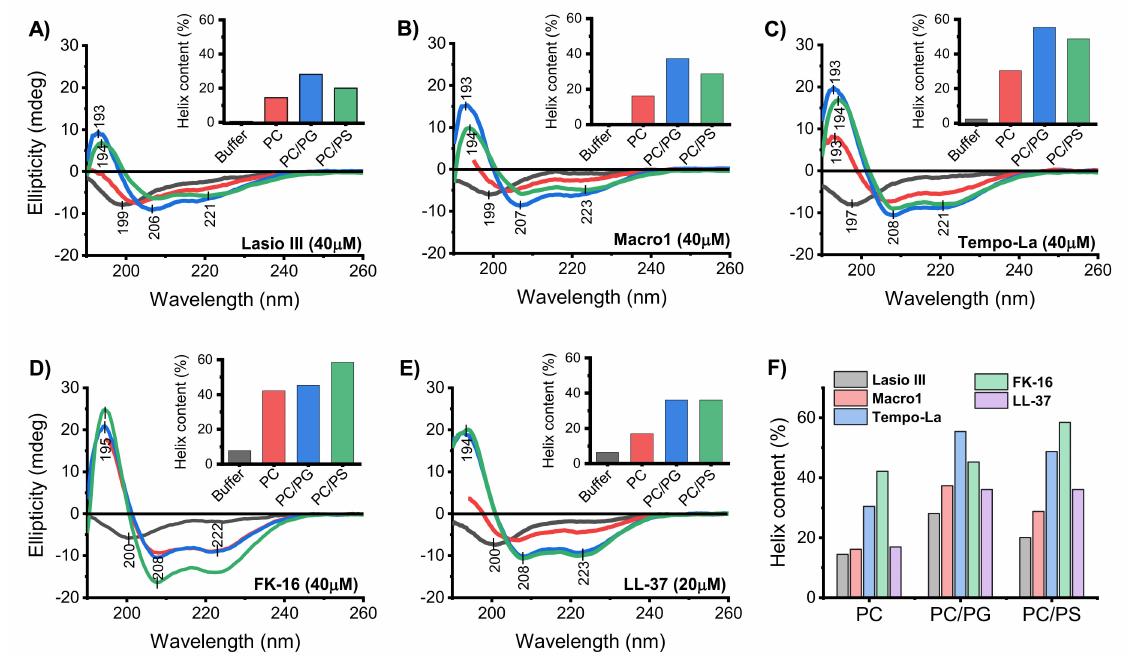
Figure 1. Peptide structural changes induced upon binding to model membranes assessed by CD spectroscopy. ( A – E ) Far-UV CD spectra in the presence and absence of the model membranes PC, PC/PG, and PC/PS. Spectra were collected at 635 µ M for ( A – D ) and at 320 µ M for ( E ) lipid concentration resulting in the same peptide-to-lipid ratio of 1:16. Insets show the calculated helix content. ( F ) Calculated peptide helix content with various lipid membranes. Helix content was calculated using the online tool (http://bestsel.elte.hu)